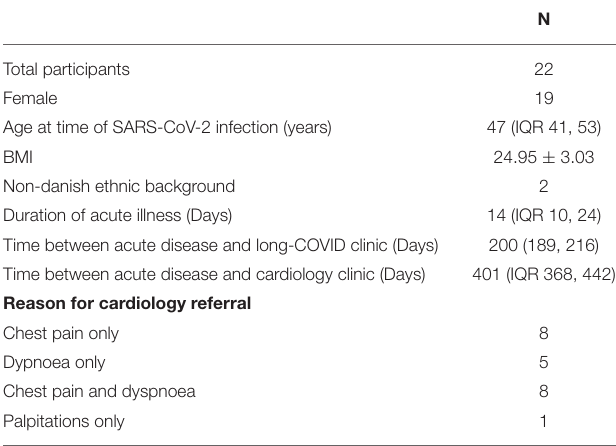
TABLE 1 | Table showing the background information of the patient group. “Duration of Acute Illness” was self-reported by patients at the time of their initial referral to the Department of Infectious